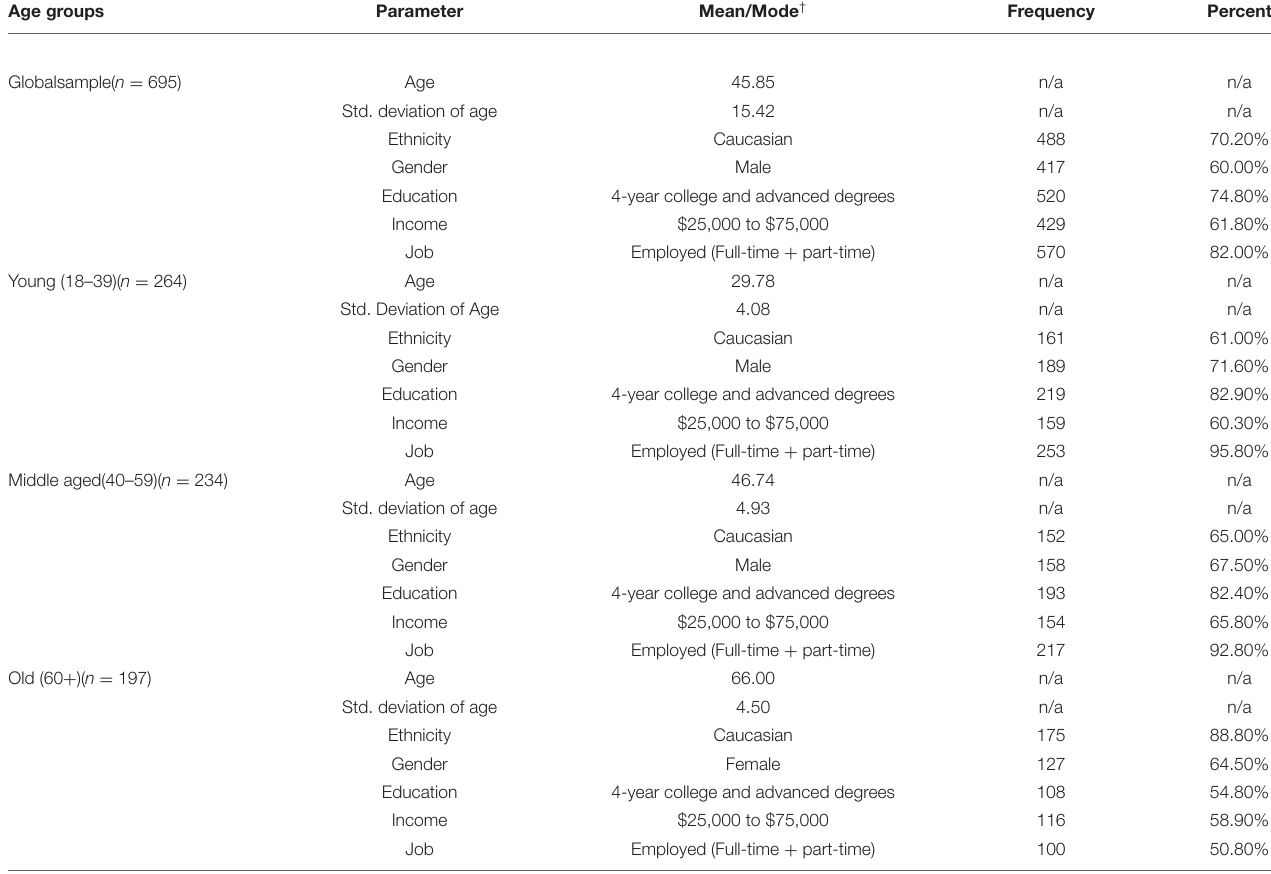
TABLE 1 | Descriptive statistics of sample demographic